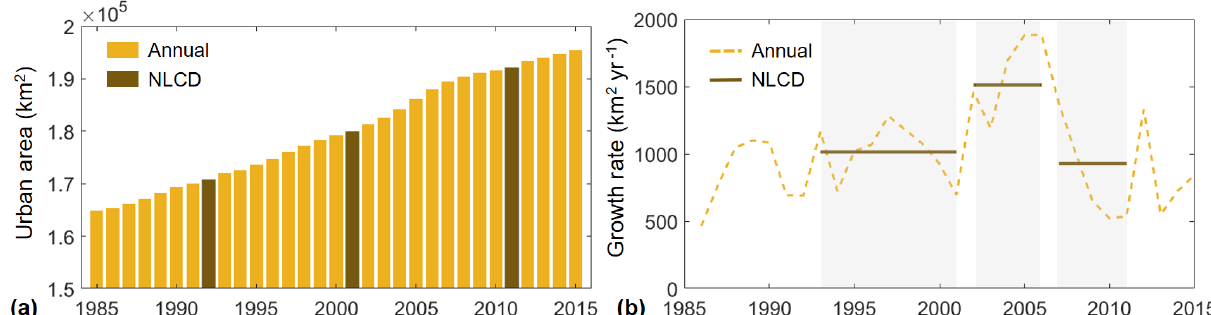
Figure 4. Annual growth of urban areas in the conterminous US (1985–2015) (a) and their annual growth rates (km 2 yr − 1 ) compared to the NLCD in the three periods (shadow frames) of 1992–2001, 2001–2006, and 2006–2011 (b)